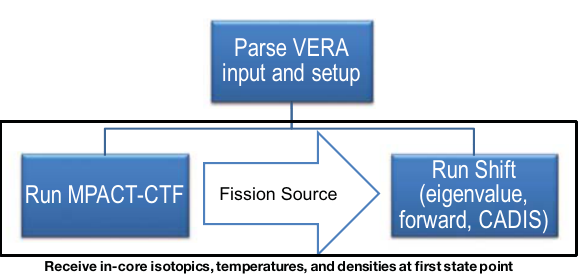
Figure 1: Diagram of Shift coupling with VERA for a single state point in a fuel